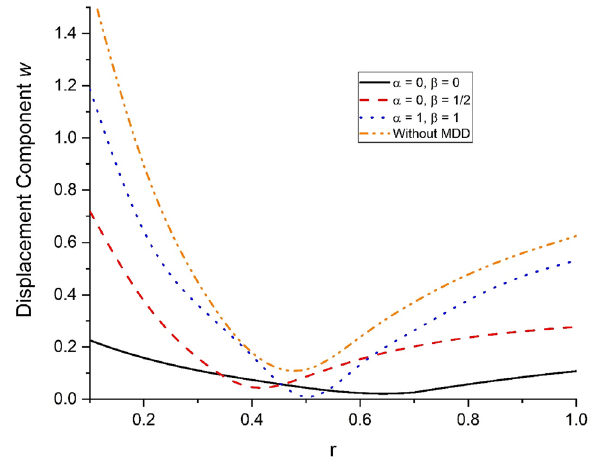
Fig. 2 Variations of displacement component w with radius